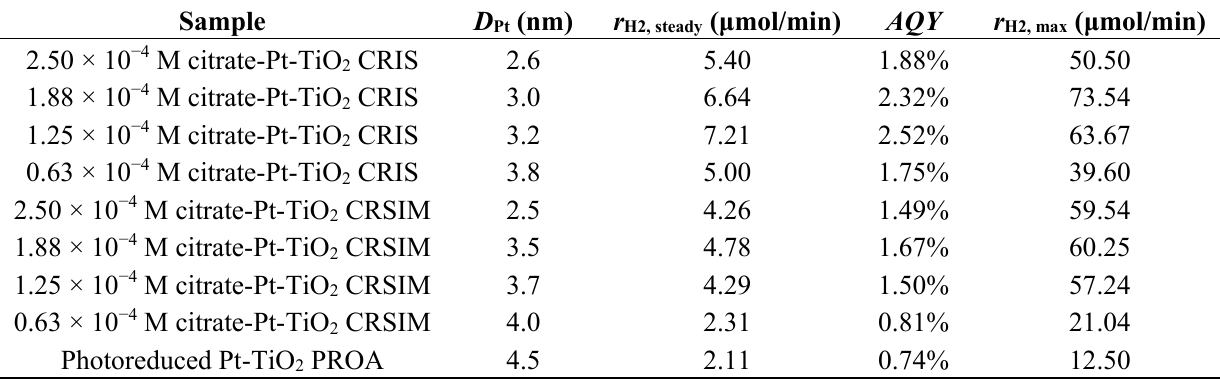
Table 2. Average Pt particle size on the prepared catalysts and the respective initial and steady state H 2 evolution rates and apparent quantum yields using 50 mM oxalic acid as a sacrificial